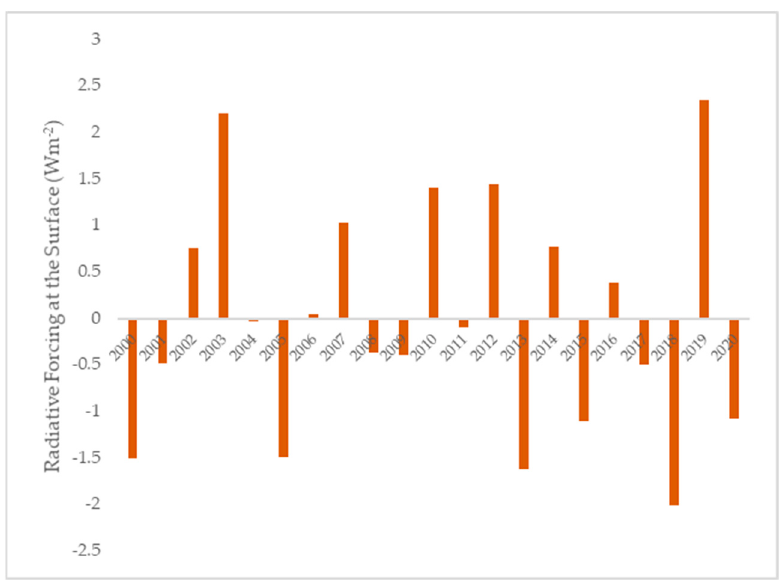
Figure 8. Annual radiative forcing for the Greenland ice sheet relative to the 2000–2020 average.